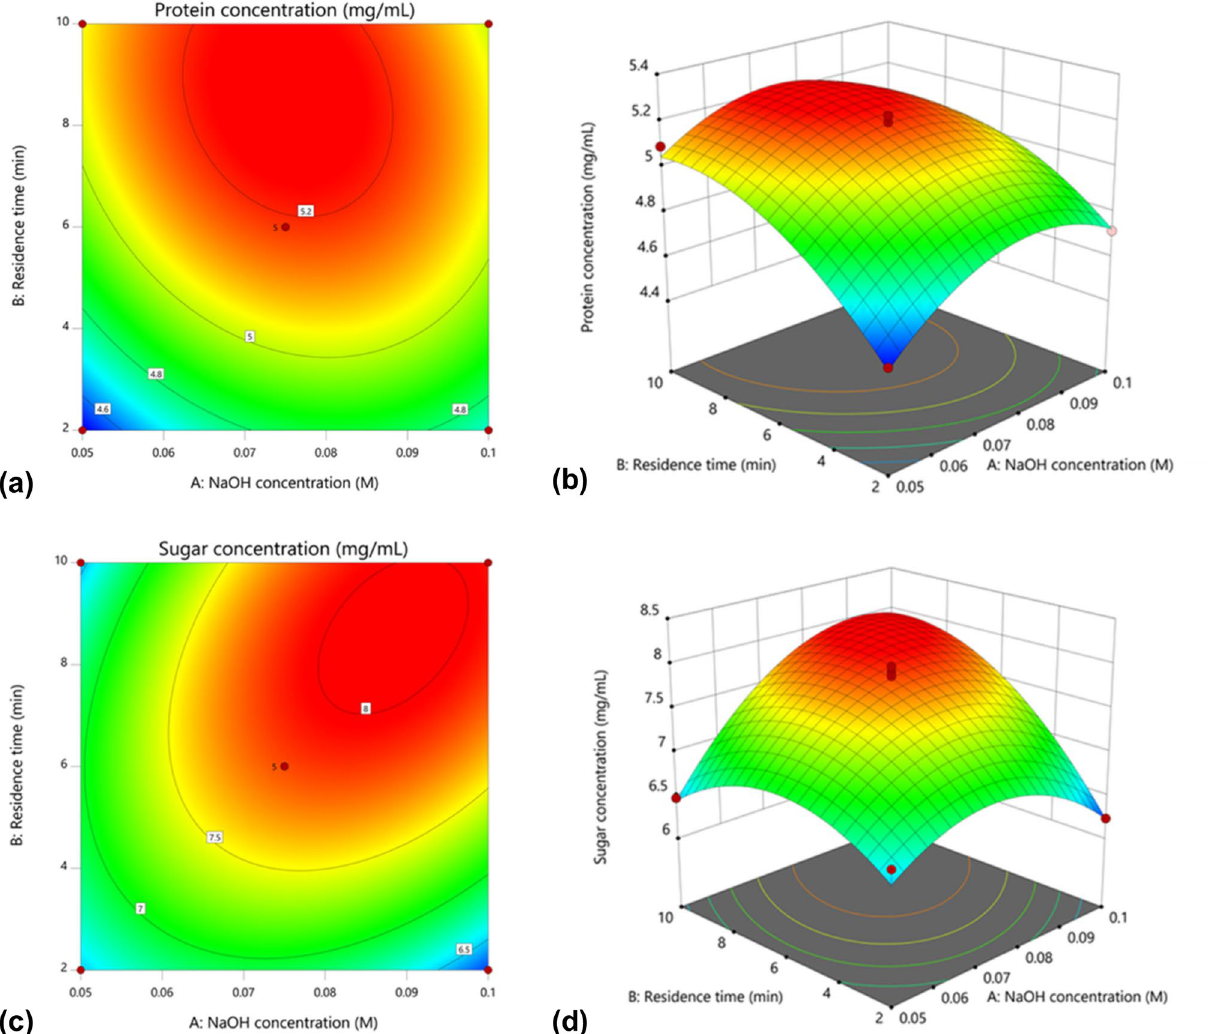
Figure 1. Contour ( a , c ) and 3D ( b , d ) plots of the interaction between NaOH concentration and residence time in the MAH cocktail of DSM and JP on protein and sugar concentration of hydrolysate. The graphs were visualized in DOE software (v 11; Stat-Ease, Inc., MN, USA; www. state ase.